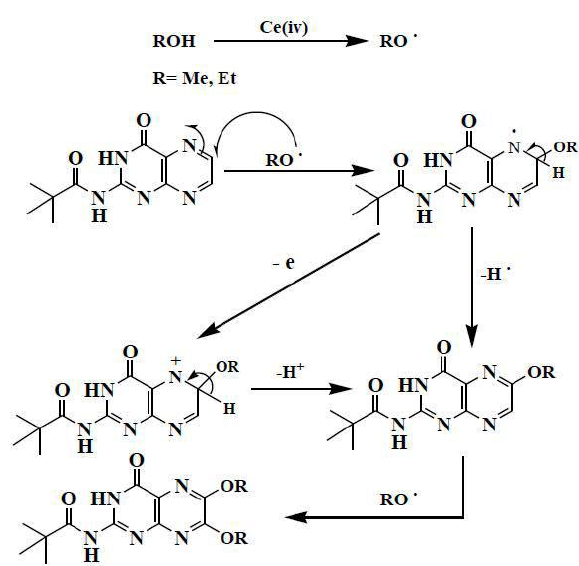
Figure 15: Plausible mechanism for the synthesis of alkoxy pterin.